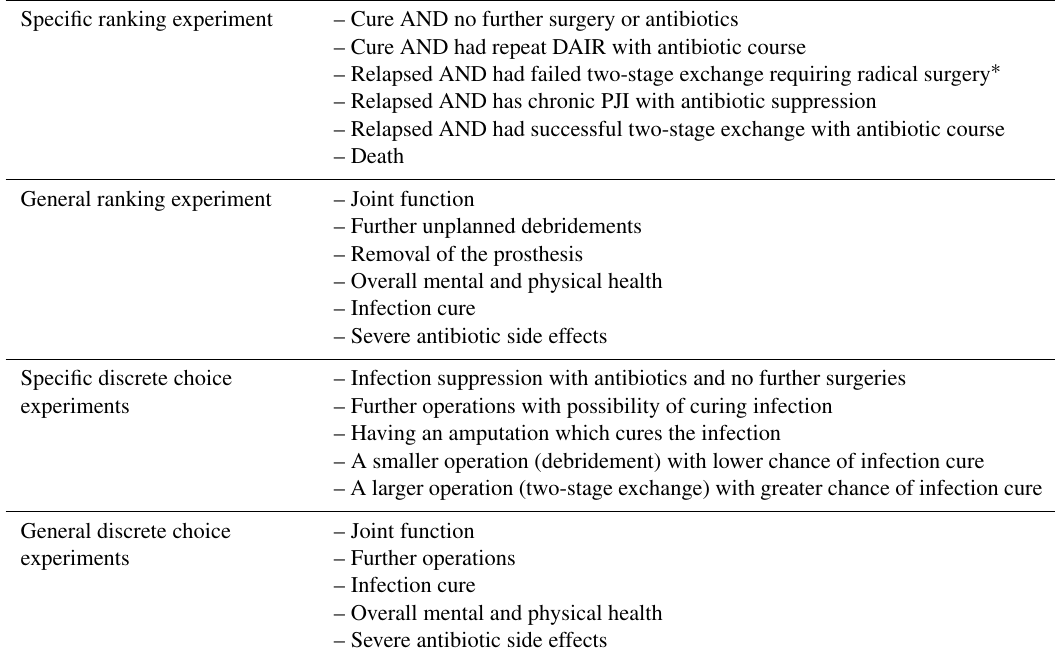
Table 1. Initial round questionnaire items for acute PJI, chronic PJI and frail patient with PJI. Specific ranking